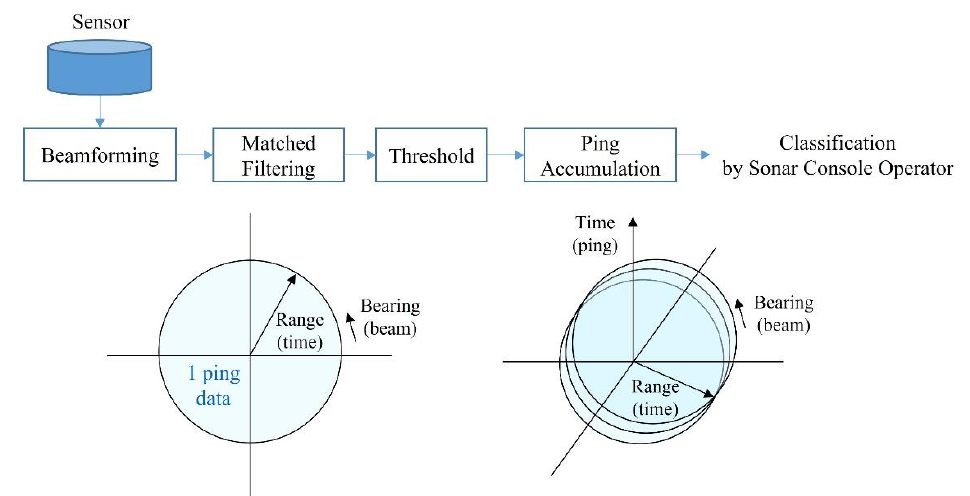
Figure 3. Target classification procedure by the sonar console operator.